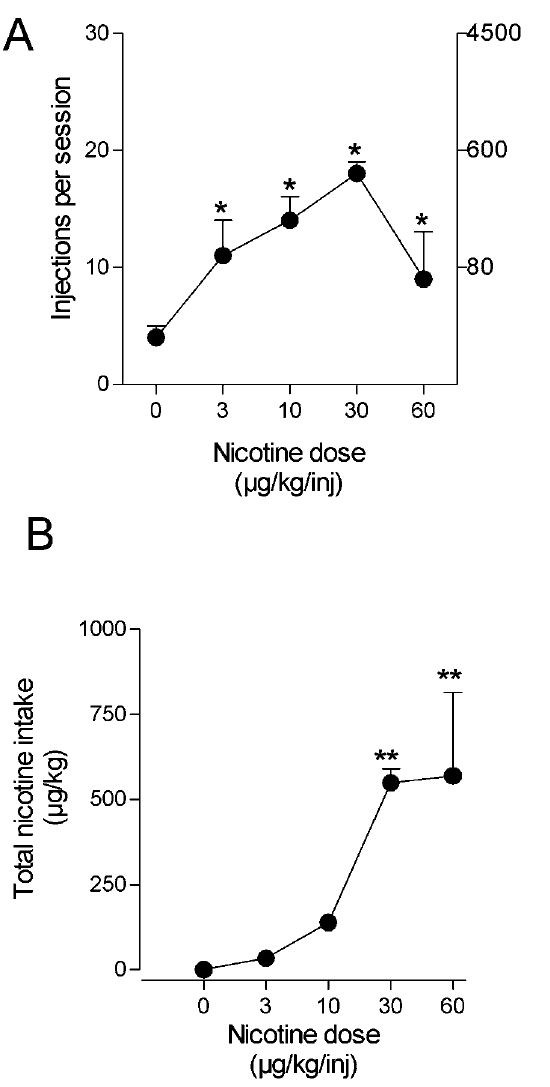
Figure 5. Influence of nicotine dose on nicotine self-administration and total nicotine intake per session under the progressive-ratio schedule. Number of nicotine injections per session and corresponding breaking- point values (highest ratio completed) under the progressive-ratio schedule ( A ) and total nicotine intake per session ( B ) are presented as a function of injection dose of nicotine (n=5). Each symbol represents the mean ( 6 SEM) of at least three sessions under each nicotine injection dose condition * P , 0.05, ** P , 0.01 post-hoc comparisons with saline vehicle (0 m g/kg per injection) conditions.